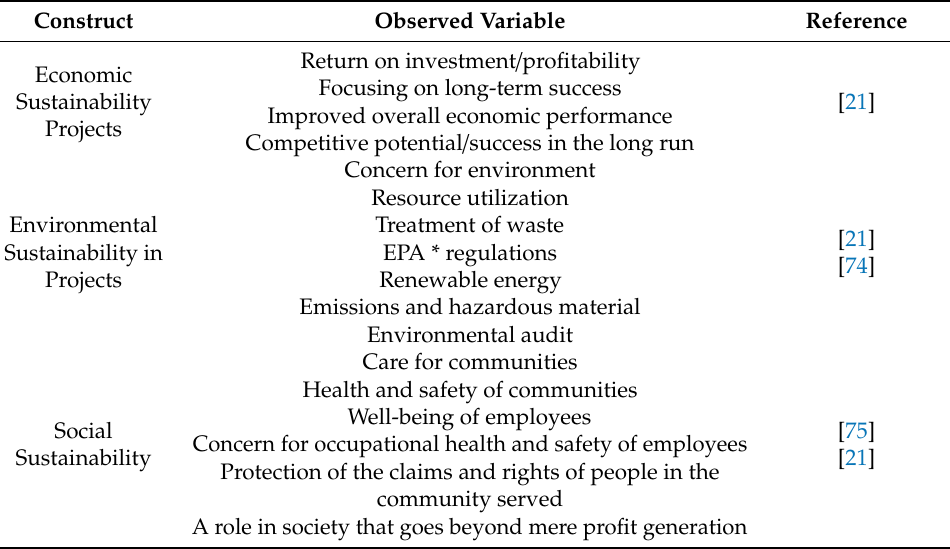
Table 1. Questionnaire